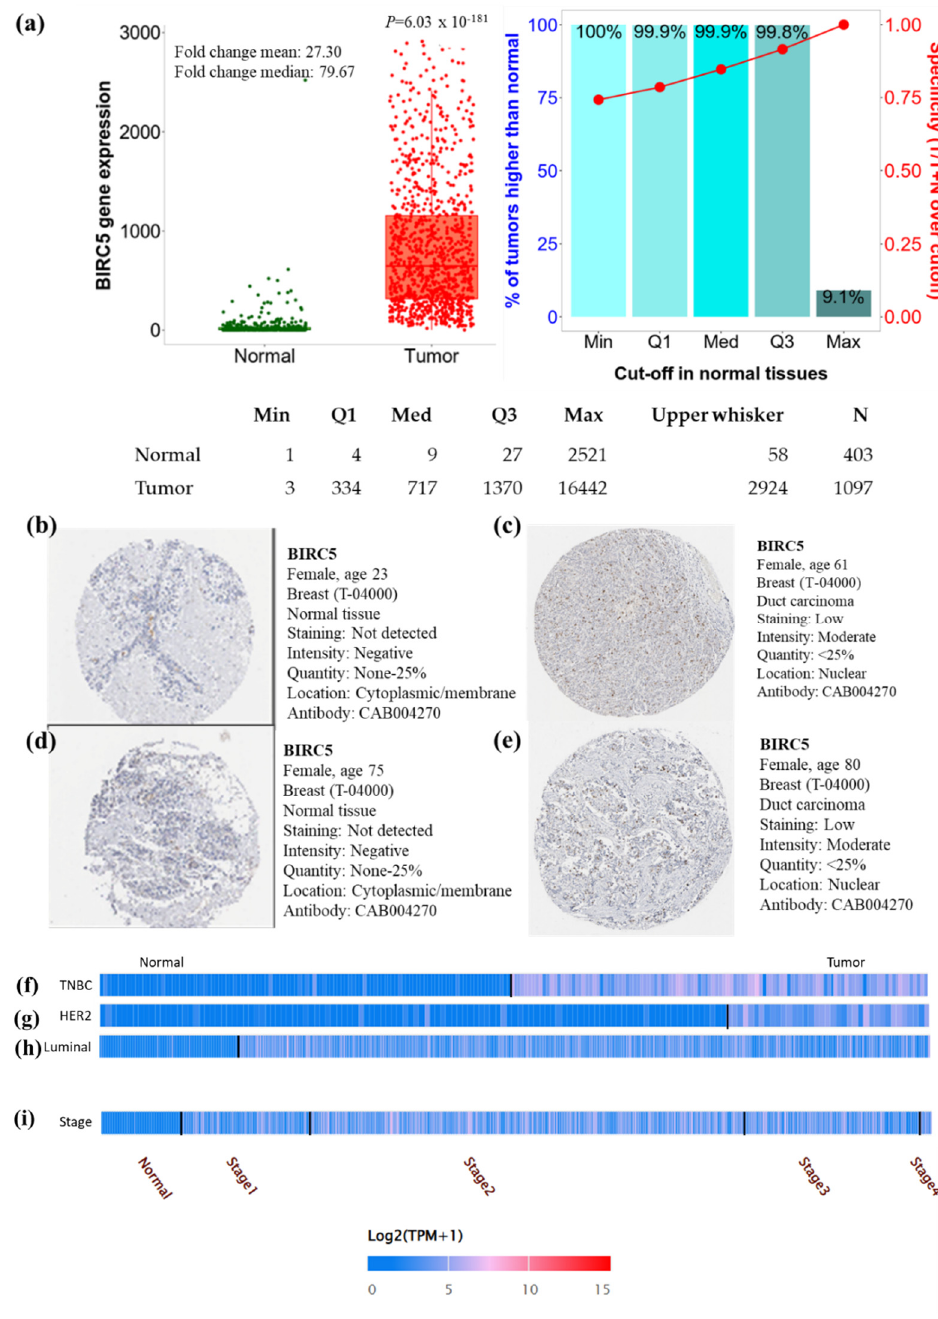
Figure 1. Breast cell cancer BIRC5 transcript and protein expression. ( a ) Plots were created using TNMplot analysis of RNAseq data using TCGA datasets (https://tnmplot.com (accessed on 2 August 2022)). In comparison to normal tissues ( n = 403), BIRC5 transcripts were considerably upregulated (fold change = 27.3) in malignancies ( n = 1097). ( b , d ) Immunohistochemistry showing the expression of the BIRC5 protein normal breast tissue with anti- BIRC5 antibody (CAB004270) and ( c , e ) BC with anti- BIRC5 antibody (CAB004270), respectively, as shown on the Human Protein Atlas website (https: //www.proteinatlas.org (accessed on 29 June 2022)). We found representative tumor images at https: //www.proteinatlas.org/ENSG00000089685-BIRC5/pathology/breast+cancer#Intensity (accessed on 29 June 2022) and for normal breast tissue at https://www.proteinatlas.org/ENSG00000089685 -BIRC5/tissue/breast (accessed on 29 June 2022). ( f – i ) demonstrates the heat map expression profile of TNBC, HER2+, and Luminal and pathological stage of